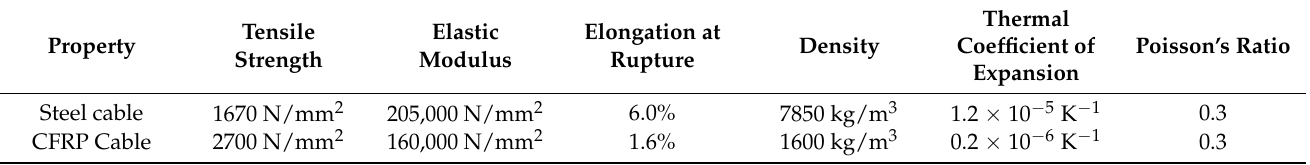
Table 5. Comparison of CFRP and steel cable properties